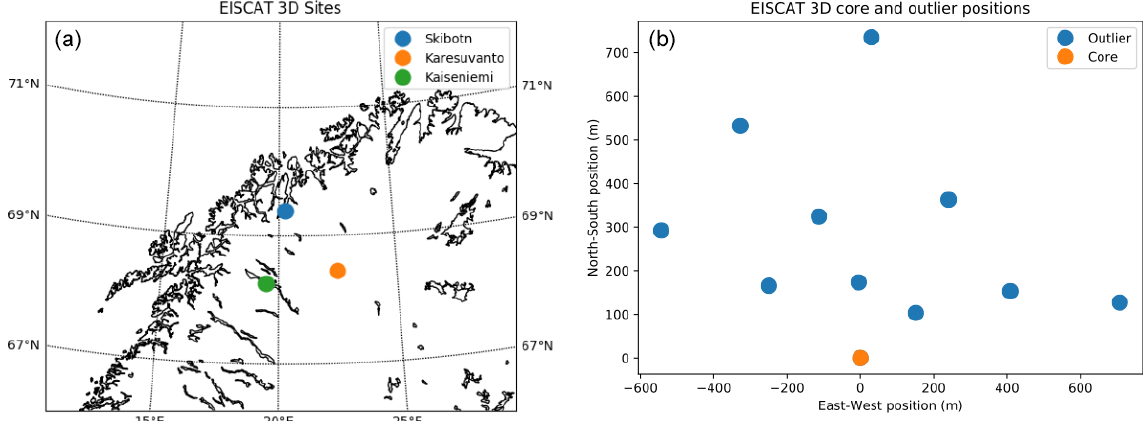
Figure 1. (a) Locations of the three receiver sites of EISCAT 3D. The Skibotn site has both transmitting and receiving capabilities, while the Kaiseniemi and Karesuvanto are only able to receive. (b) Planned distribution of antenna modules at the Skibotn site. Note that only the Skibotn site is planned to have outlier antenna modules intended for interferometric